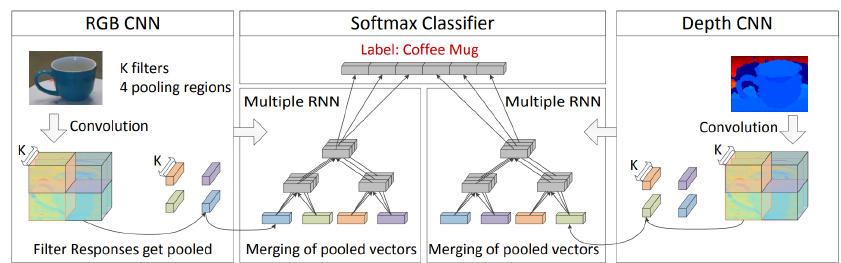
Figure 1. Network architecture to process RGB and depth images separately to learn low level features. Multiple RNNs are then used to find higher level features. Finally feature vectors are concatenated for a final softmax classification layer. Image source: